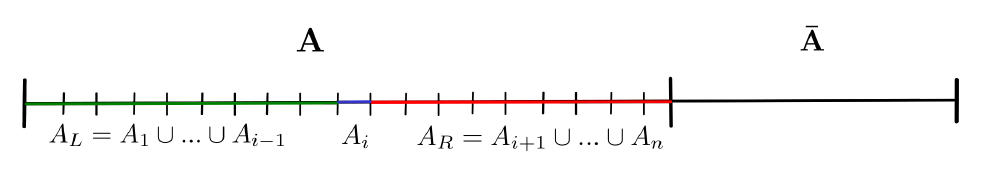
Figure 1: A bipartite system, with subregion A and its complement ¯ A , and with A par- titioned into n subintervals. Partial entanglement entropy divides up the von Neu- mann entropy of A amongst each of these subintervals. The entanglement contour is roughly speaking the n → ∞